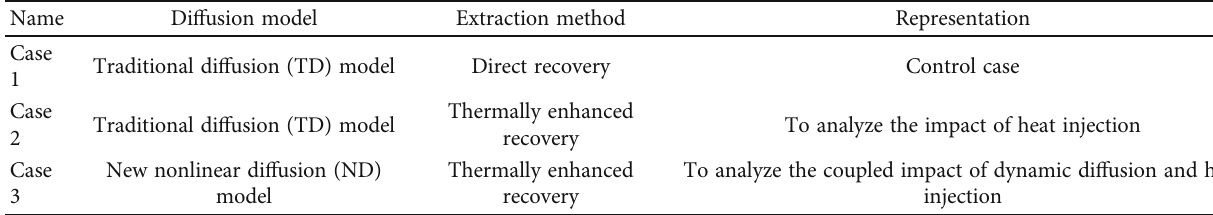
Table 5: Three cases for simulation and